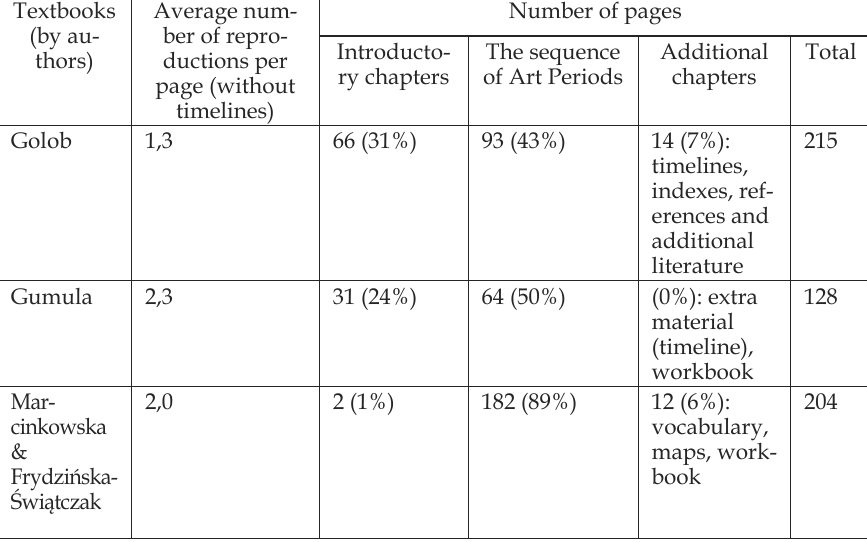
Table 2: The comparison of a content structure Textbooks (by